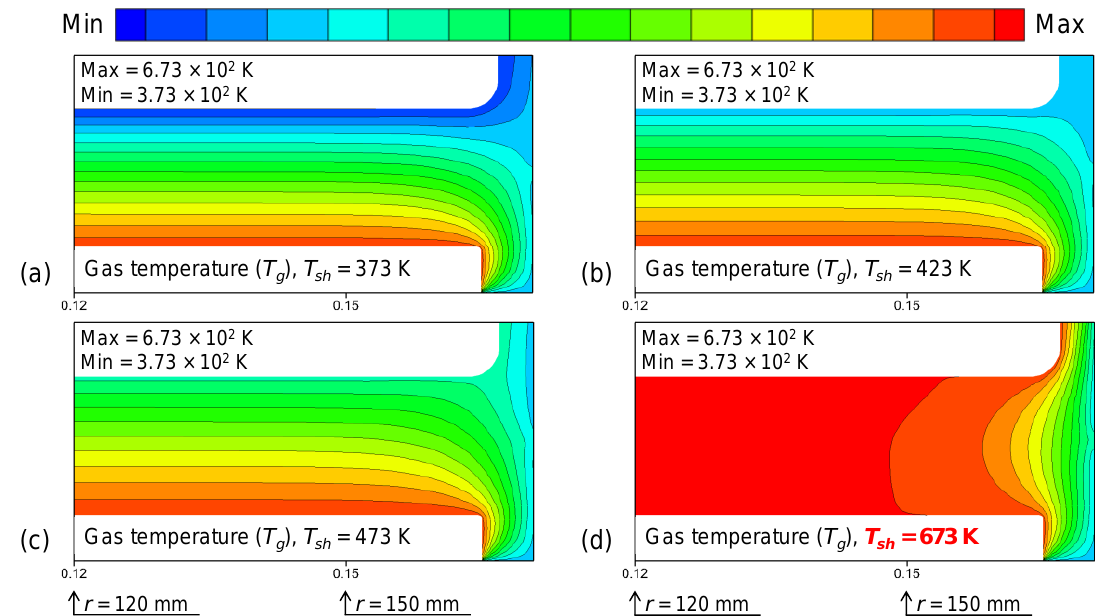
Figure 3. Spatial variations in the gas temperature ( T g ) distributions (K) for ( a ) Case 2 ( T sh = 373 K), ( b ) Case 3 ( T sh = 423 K), ( c ) Case 4 ( T sh = 473 K), and ( d ) Case 5 ( T sh = 673 K) for r ≥ 120 mm.